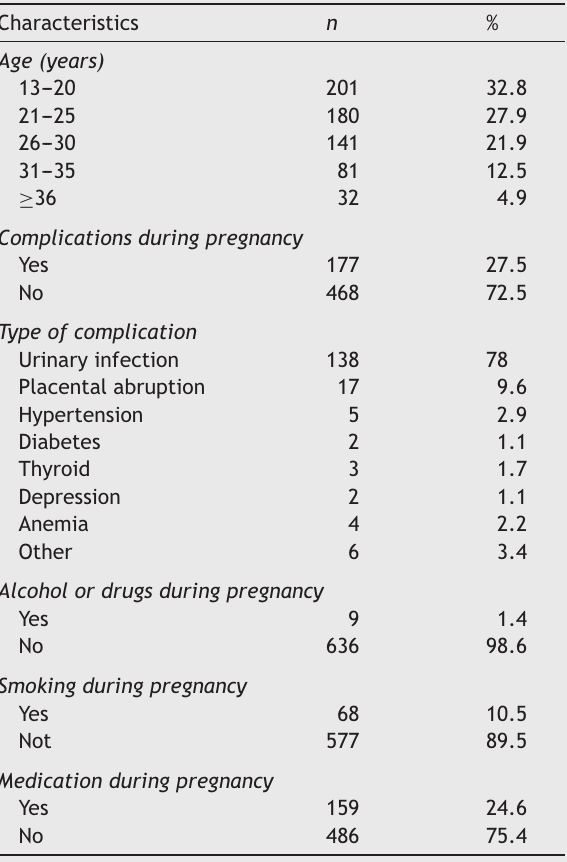
Gestational profile of mothers of babies screened in the